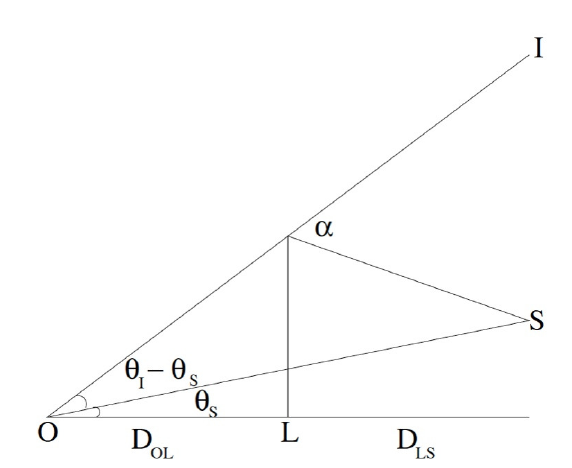
Figure 1. Light paths of gravitational